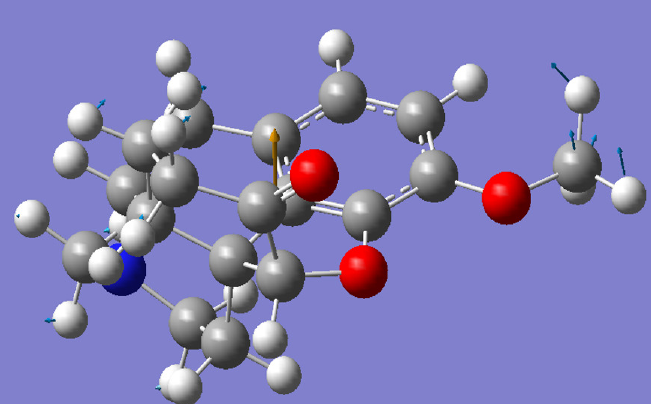
Figure 5. Hydrocodone, the lowest 1.40 THz normal mode. A view of atomic motions (blue arrows) and dipole moment derivative (brown